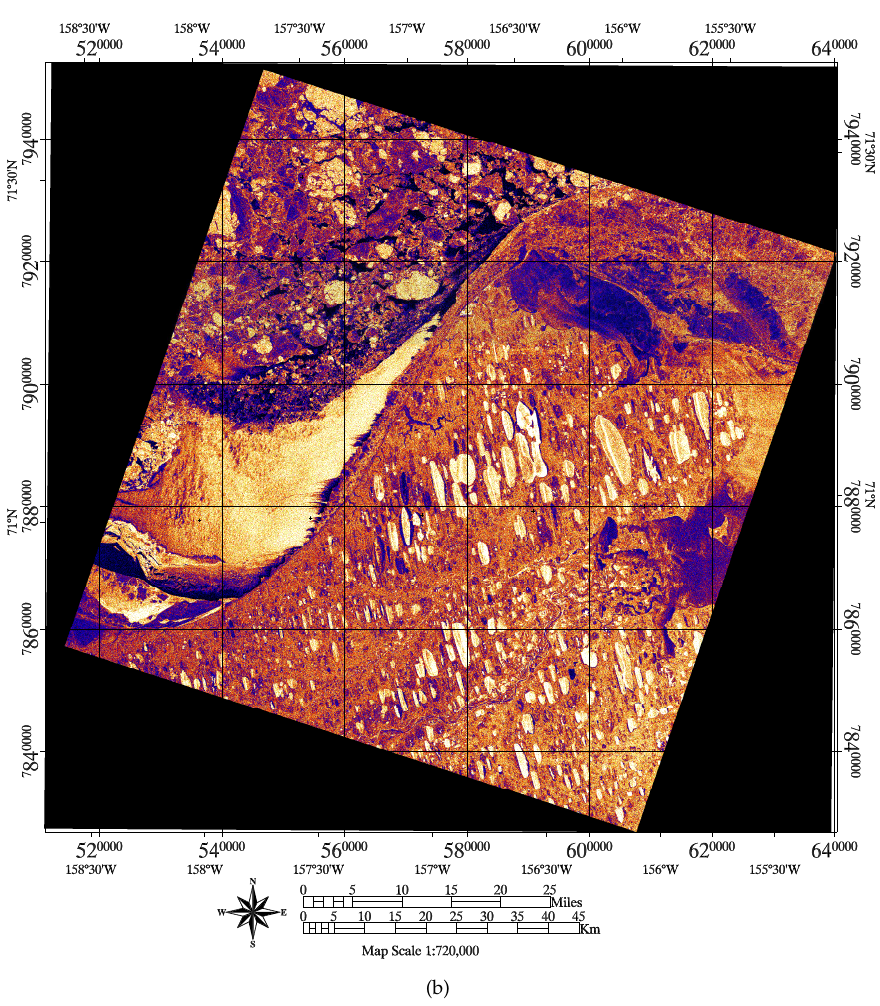
Figure 4. ( a ) ERS-2 SAR data of Barrow area from March 2003. Original grey-scale SAR data. An example of landfast ice. Chukchi Sea is west of land, Elson Lagoon is N and NE of land. Copyright European Space Agency; ( b ) ERS-2 SAR data of Barrow area from March 2003. Color-enhanced version created using a spectral transformation. An example of landfast ice. Chukchi Sea is west of land, Elson Lagoon is N and NE of land. Copyright European Space